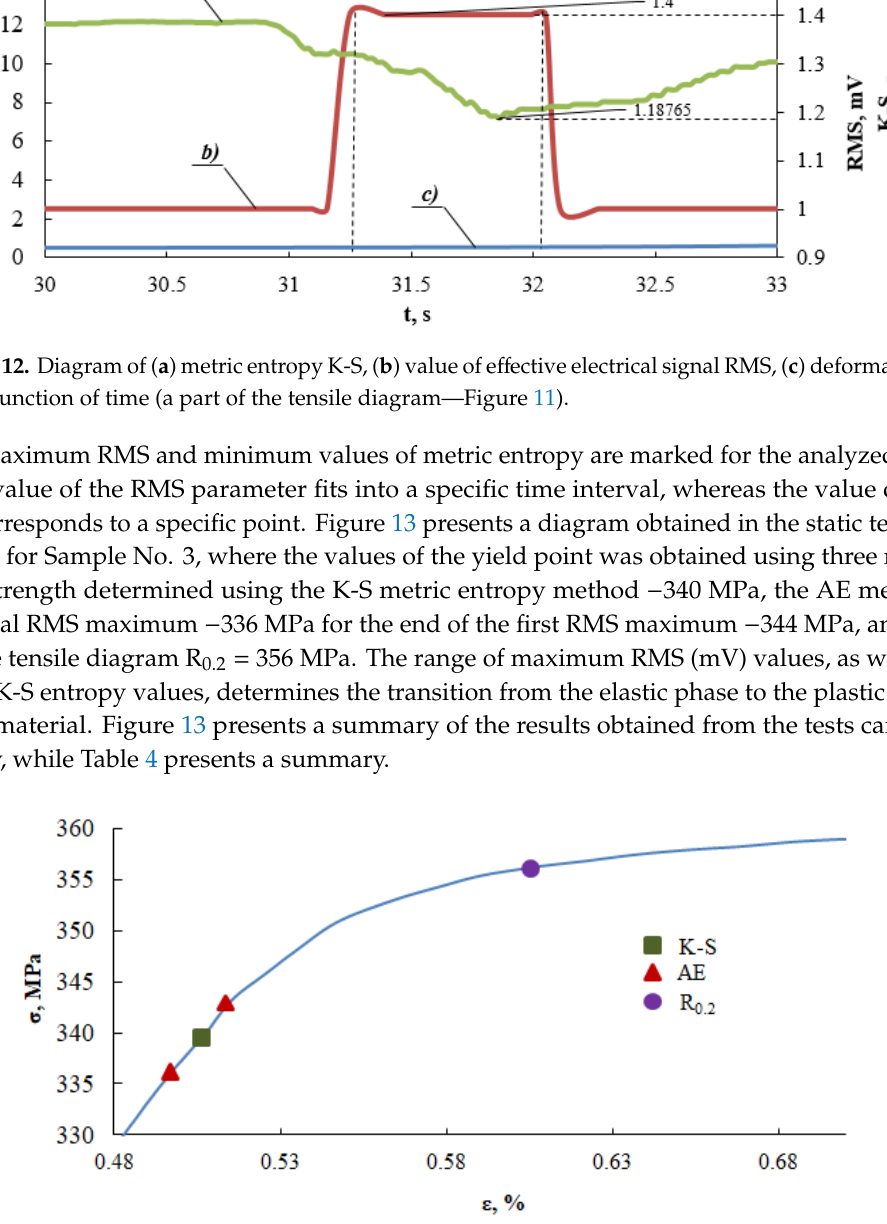
Figure 13. A fragment of the static tensile diagram for Sample No. 3 (Figure 2), with marked values of the yield point determined using the K-S metric entropy method, K – S ; the first local RMS maximum; the end local RMS maximum of acoustic emission (AE), with a marked value of R 0.2 , determined in the static tensile test.